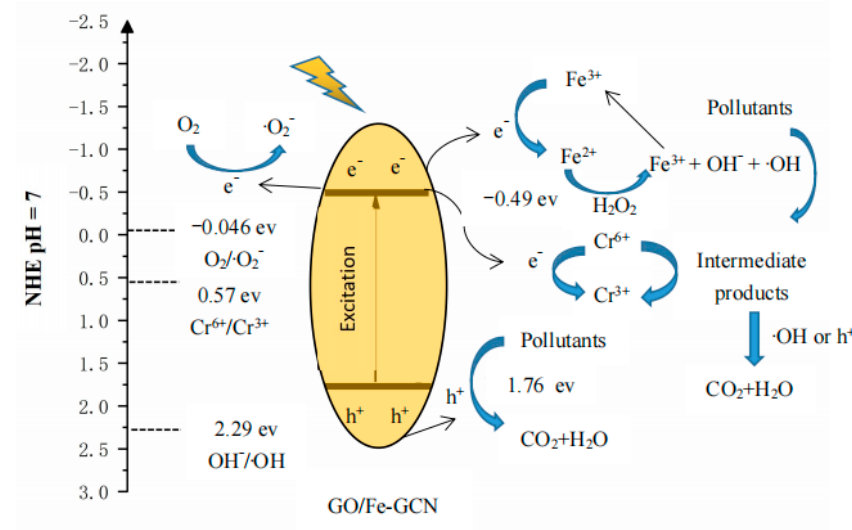
Figure 10. Proposed mechanism of the simultaneous Cr(VI) reduction and organic pollutants degradation in the photo-Fenton catalytic system.